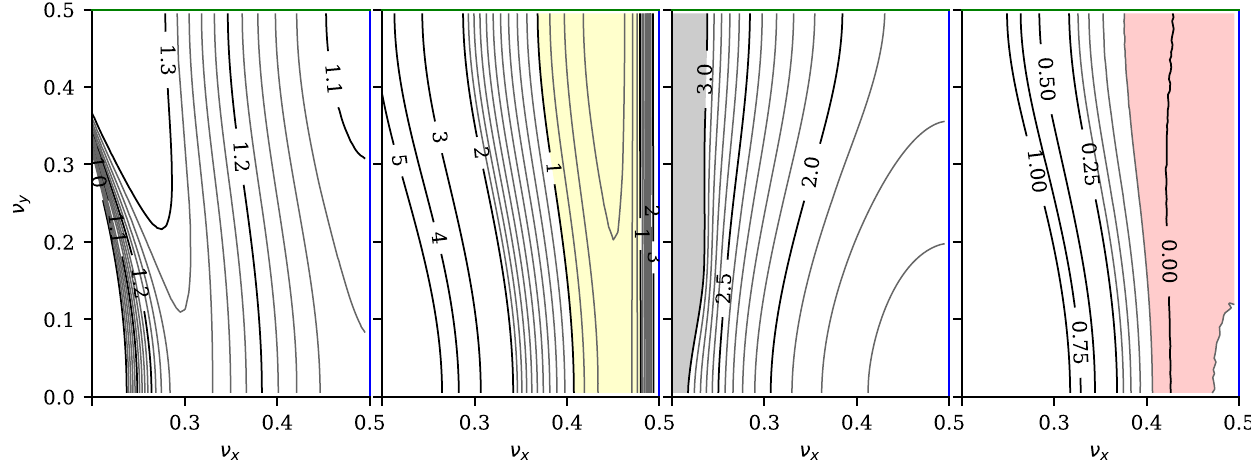
(yellow).FIG. 4. From left to right: (1) optimized b 1 for minimal TME emittance ratio F for b 1 < 1 . 3 , (2) resulting F up to 5, with sub-TME region in yellow, (3) horizontal damping partition J , invalid region in gray, (4) momentum compaction integral I 1 up to 1, with the red x area indicating j I 1 j < 0 . 05